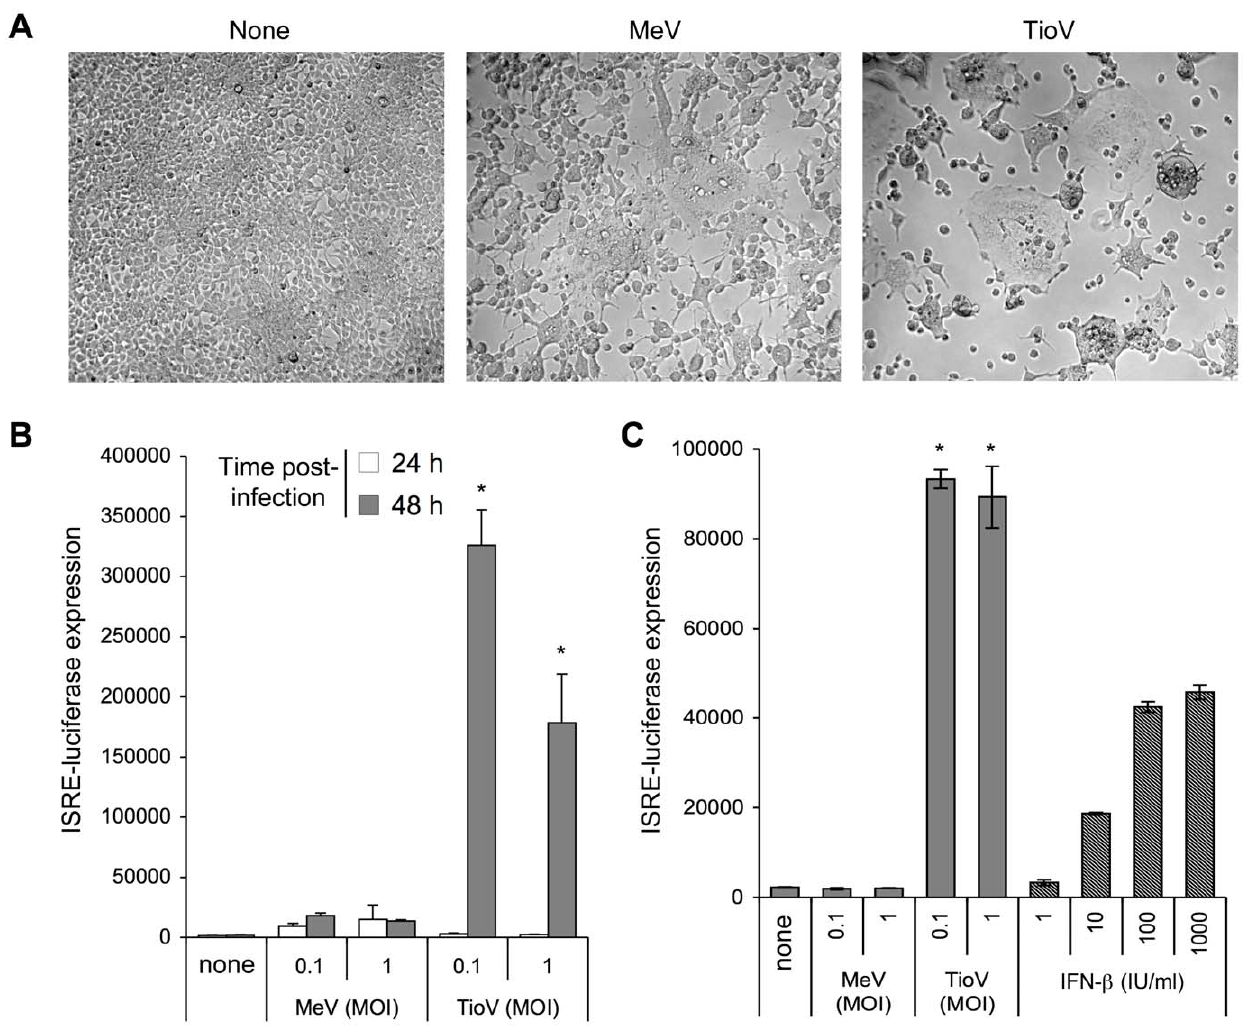
Figure 2. Activation of ISRE-dependent gene expression by MeV or TioV infection. HEK-293 cells stably transfected with an ISRE-luciferase reporter gene (STING-37 reporter cell line) were infected with MeV or TioV. ( A ) Bright field microscopy of cell cultures at 48 h post-infection (MOI =1). ( B ) Luciferase expression was determined at 24 h and 48 h post-infection. ( C ) Culture supernatants from (B) were collected at 48 h post-infection, clarified by centrifugation, UV-inactivated and added to culture wells containing STING-37 cells. Alternatively, culture medium was supplemented with increasing doses of recombinant IFN- b . After 24 h, luciferase expression was determined. Luciferase activity in culture supernatants from (B) was below 1,400 luciferase activity units (data not shown). Experiment was performed in triplicates, and data represent means 6 SD. *indicates that differences observed between MeV and TioV-infected cells were statistically significant (p-value , 0.01).